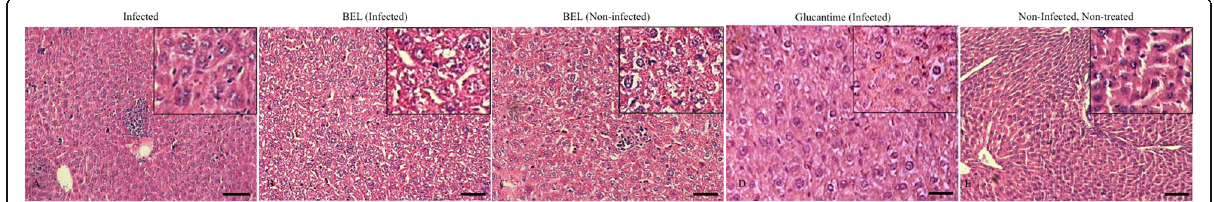
Fig. 2 Histopathology analysis of the liver section. Liver of infected control ( a ) showed portal inflammation; the inset shows preserved hepatocytes and Kupfer cells. Infected ( b ) and non-infected ( c ) animals treated with 30 nM of BEL showed degeneration of hepatocytes (details in the insets). Liver of infected animals treated with Glucantime did not show signs of histological changes ( d ). Histological section of the liver from healthy animals ( e